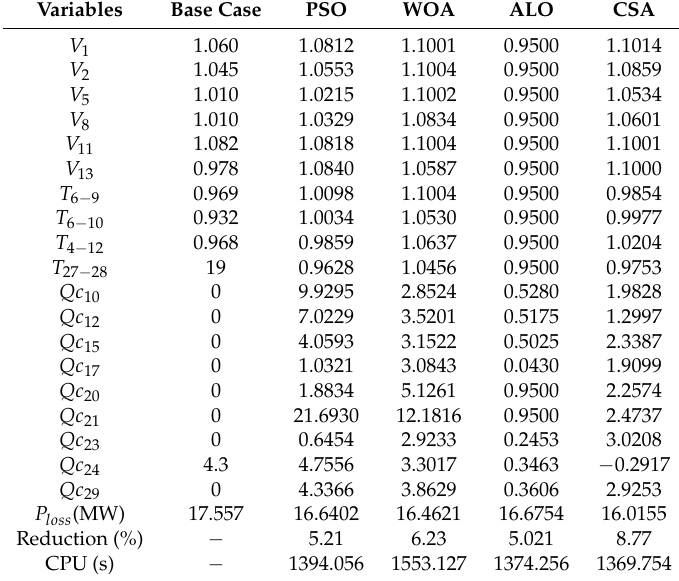
Figure 4. Performance loss convergence characteristics for IEEE 30-bus test using PSO (blue), WOA (green), ALO (black) and CSA(red). Table 4. Comparison of simulation results for IEEE 30-bus using various